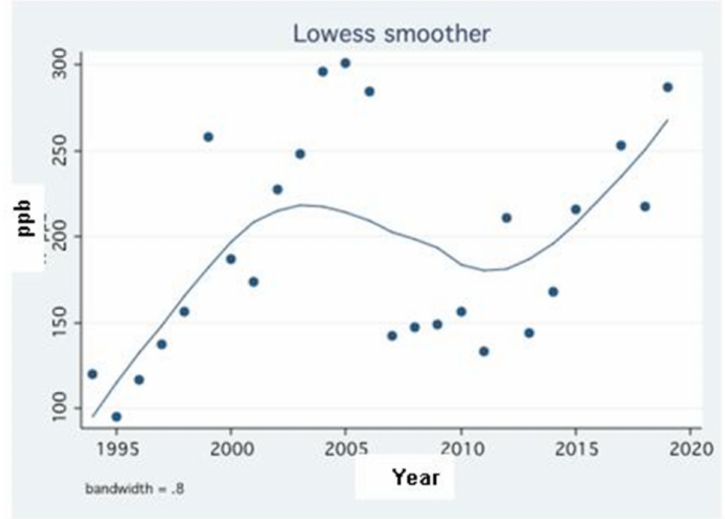
Figure 7. LOWESS smoother plot (bandwidth = 0.8) plot of the temporal (1994–2018) changes in annual averages of TP concentrations (ppb) in the Lake Agmon outflow.